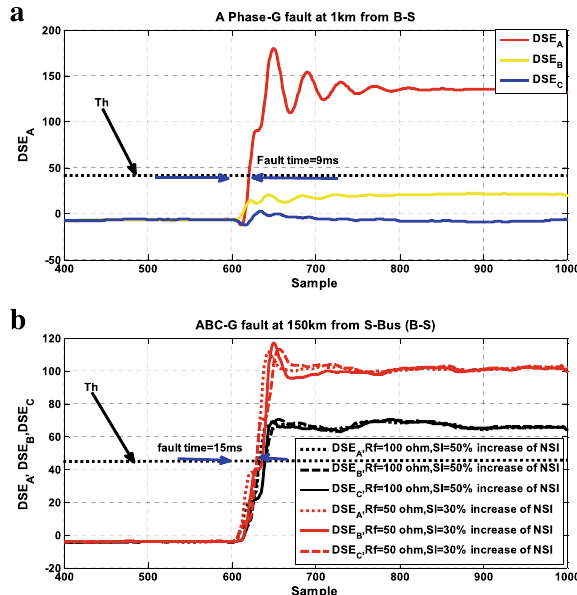
Fig. 4 a . Rf =100 Ω , A phase-G fault, 1 km from B-S. b . Rf =50 Ω , 100 Ω , SI = 30% and 50% increase of NSI, ABC phase- G fault at 150 km from